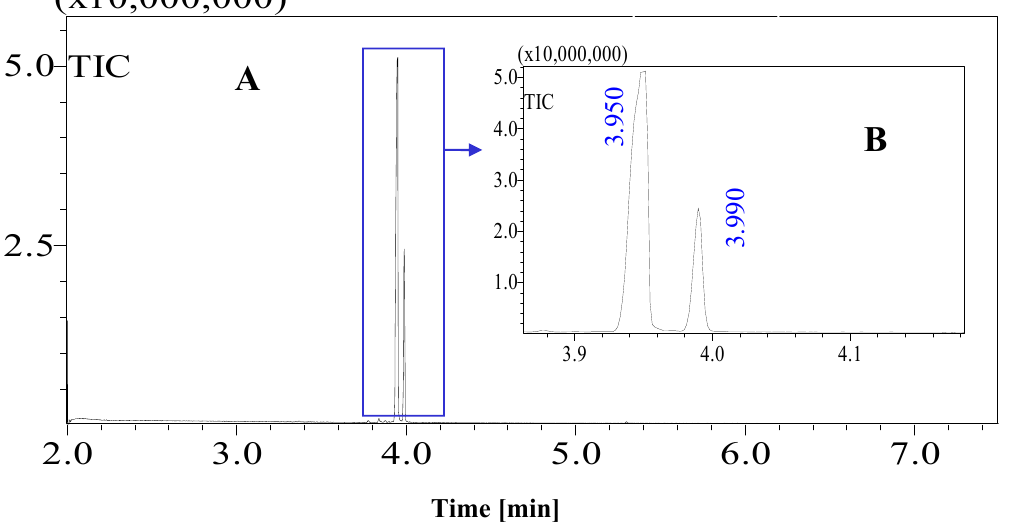
Figure 3. Total ion chromatogram (TIC) of standard D -glucose. Chromatograph of the oximated and silylated glucose sample was obtained. Glucose syn and anti-forms were observed at 3.95 and 3.99 min. ( A ) Total chromatogram of a standard glucose sample for a 7-min measurement; ( B ) the glucose standard sample from 3.9–4.1 min.